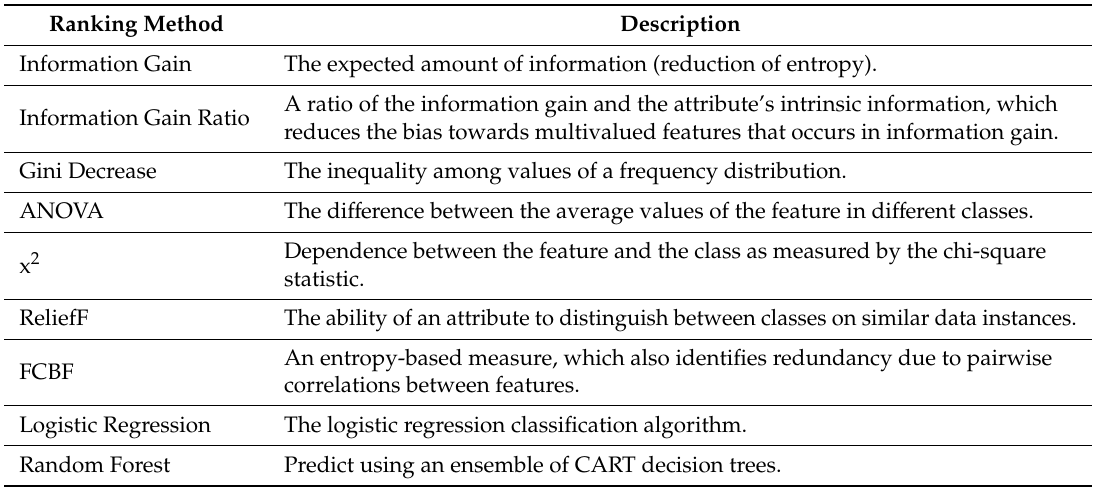
Table 6. The ranking methods used in the